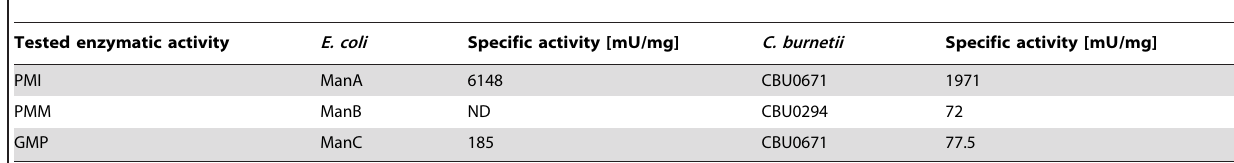
Table 3. Enzymatic activity of C. burnetii CBU0671 and CBU0294 in bacterial crude extracts.